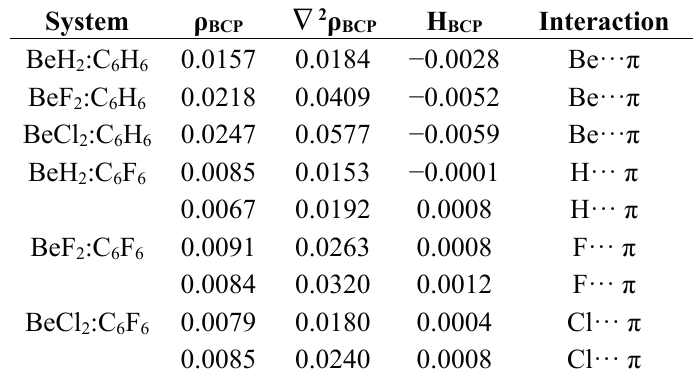
Table 3 AIM parameters (in au) for the BCPs corresponding to the intermolecular interactions in the BeR 2 :C 6 X 6 binary systems, the electron density, ρ BCP , its Laplacian, ∇ 2 ρ BCP , and the total electron energy density, H BCP